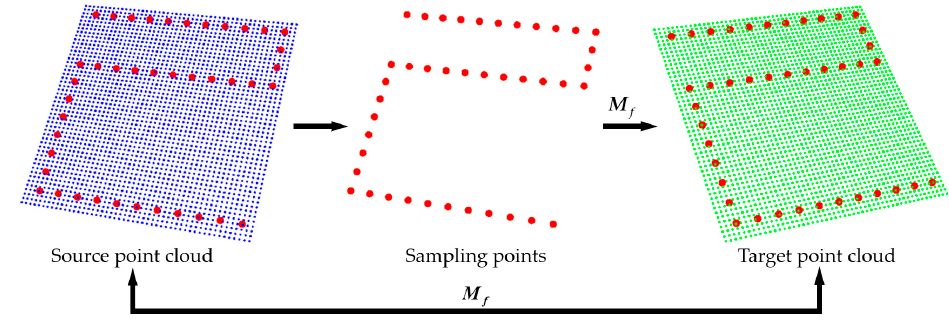
Figure 5. Illustration of the mapping of flatness sampling points. Sampling points ( red dots) from the coordinate system of the source point cloud ( blue one) to the coordinate system of the target point cloud ( green one).